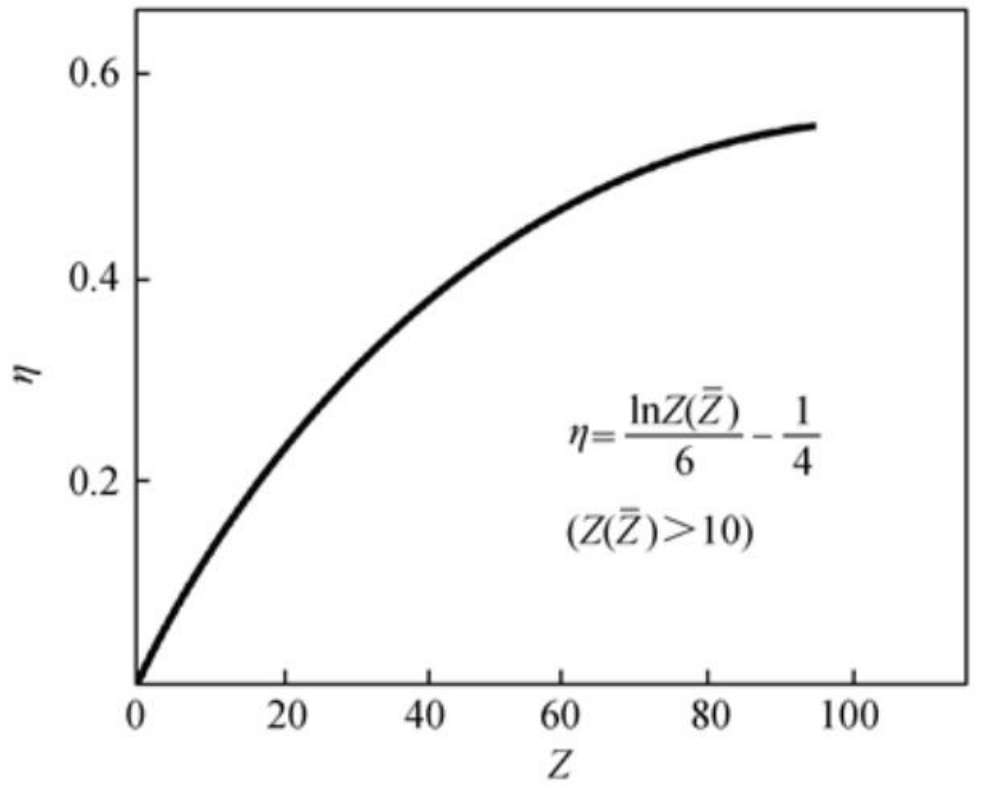
Figure 5. Relationship between atomic number Z and backscattering coefficient η .